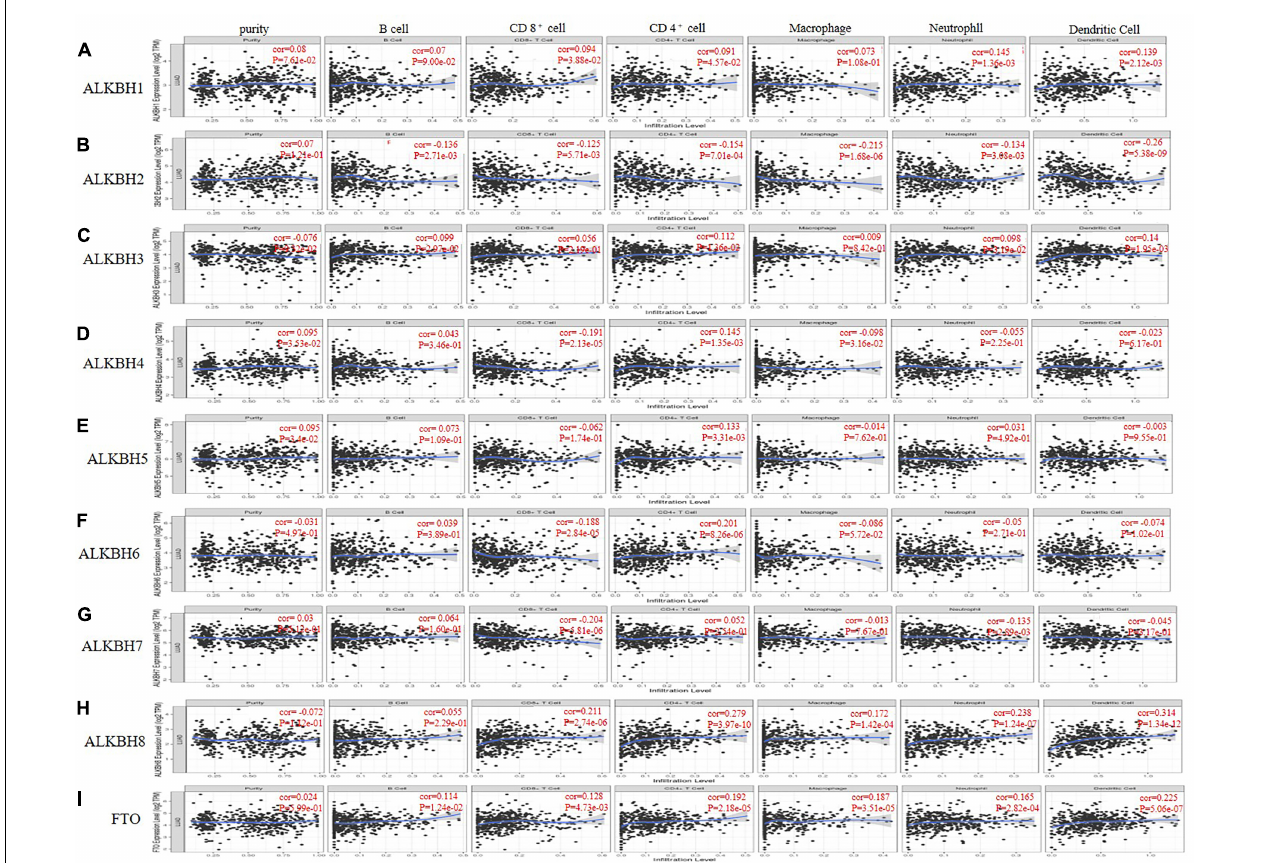
FIGURE 6 | The correlations between differentially expressed AlkB family and immune cell infiltration. (A–I) The effect of ALKBH1-8 and FTO on the immune cell infiltration analyzed by